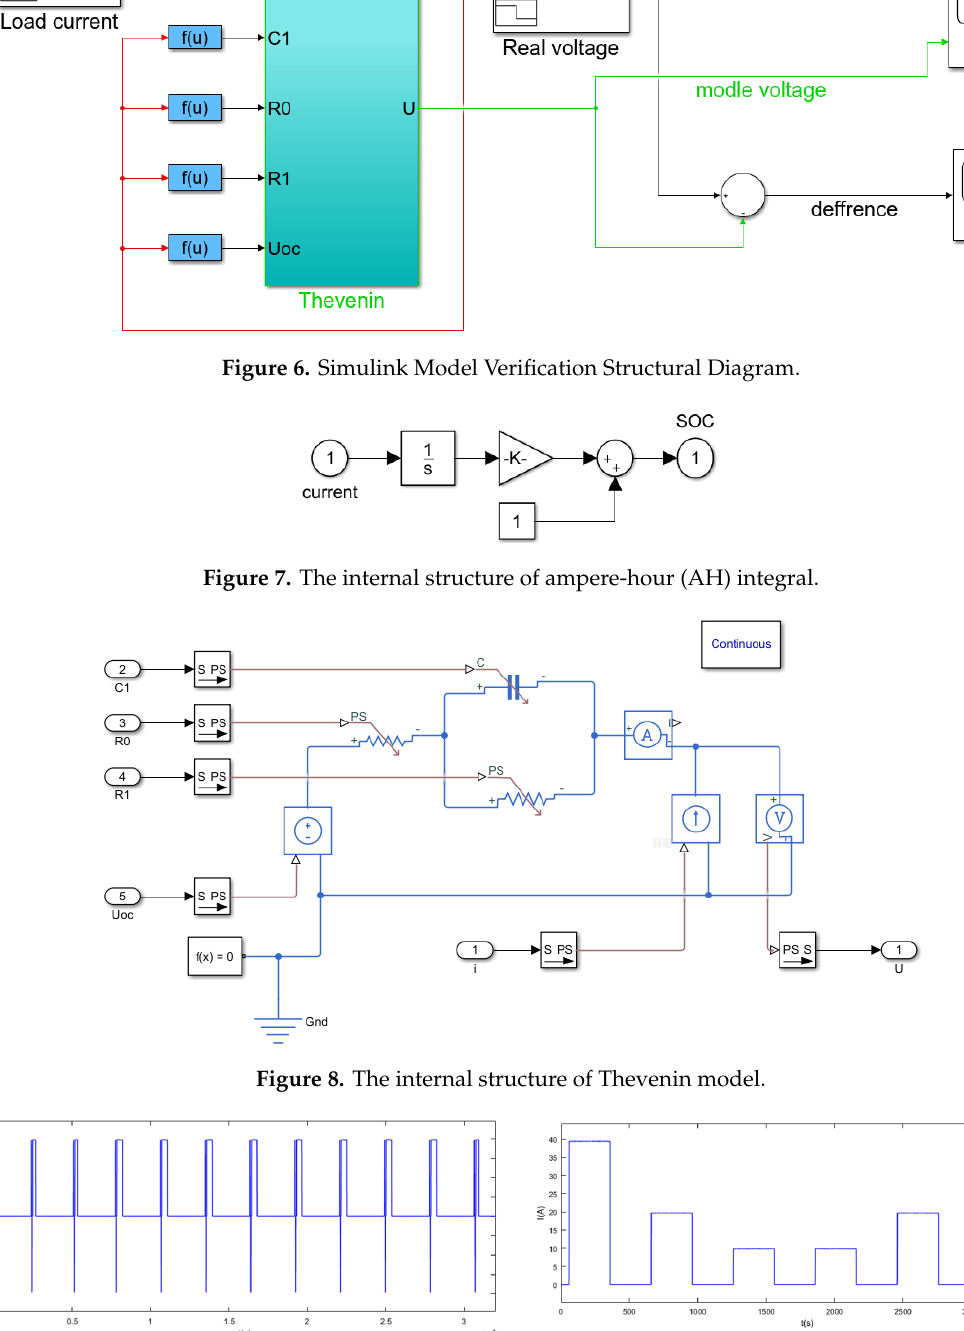
Figure 6. Simulink Model Verification Structural Diagram.